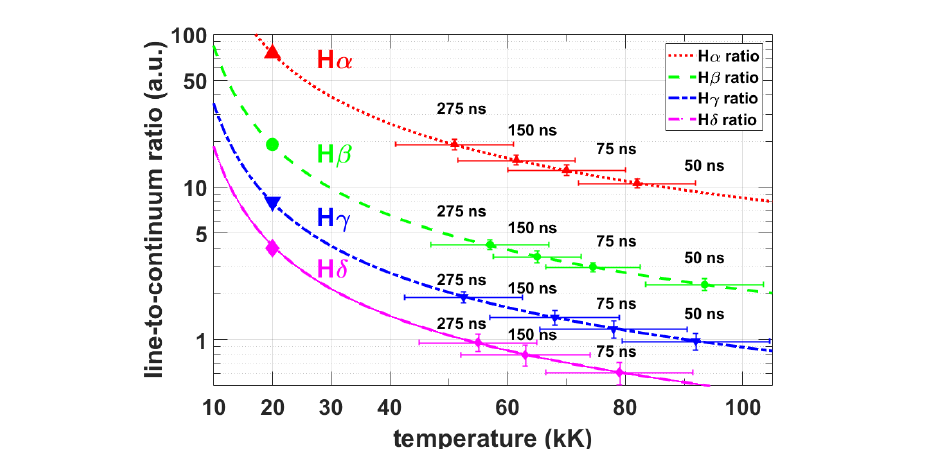
Figure 4. Computed and measured line-to-continuum ratios for selected time delays. Computed ratios of 75, 19, 8, and 4 are highlighted for H α , H β , H γ , and H δ , respectively, at 20 kK.